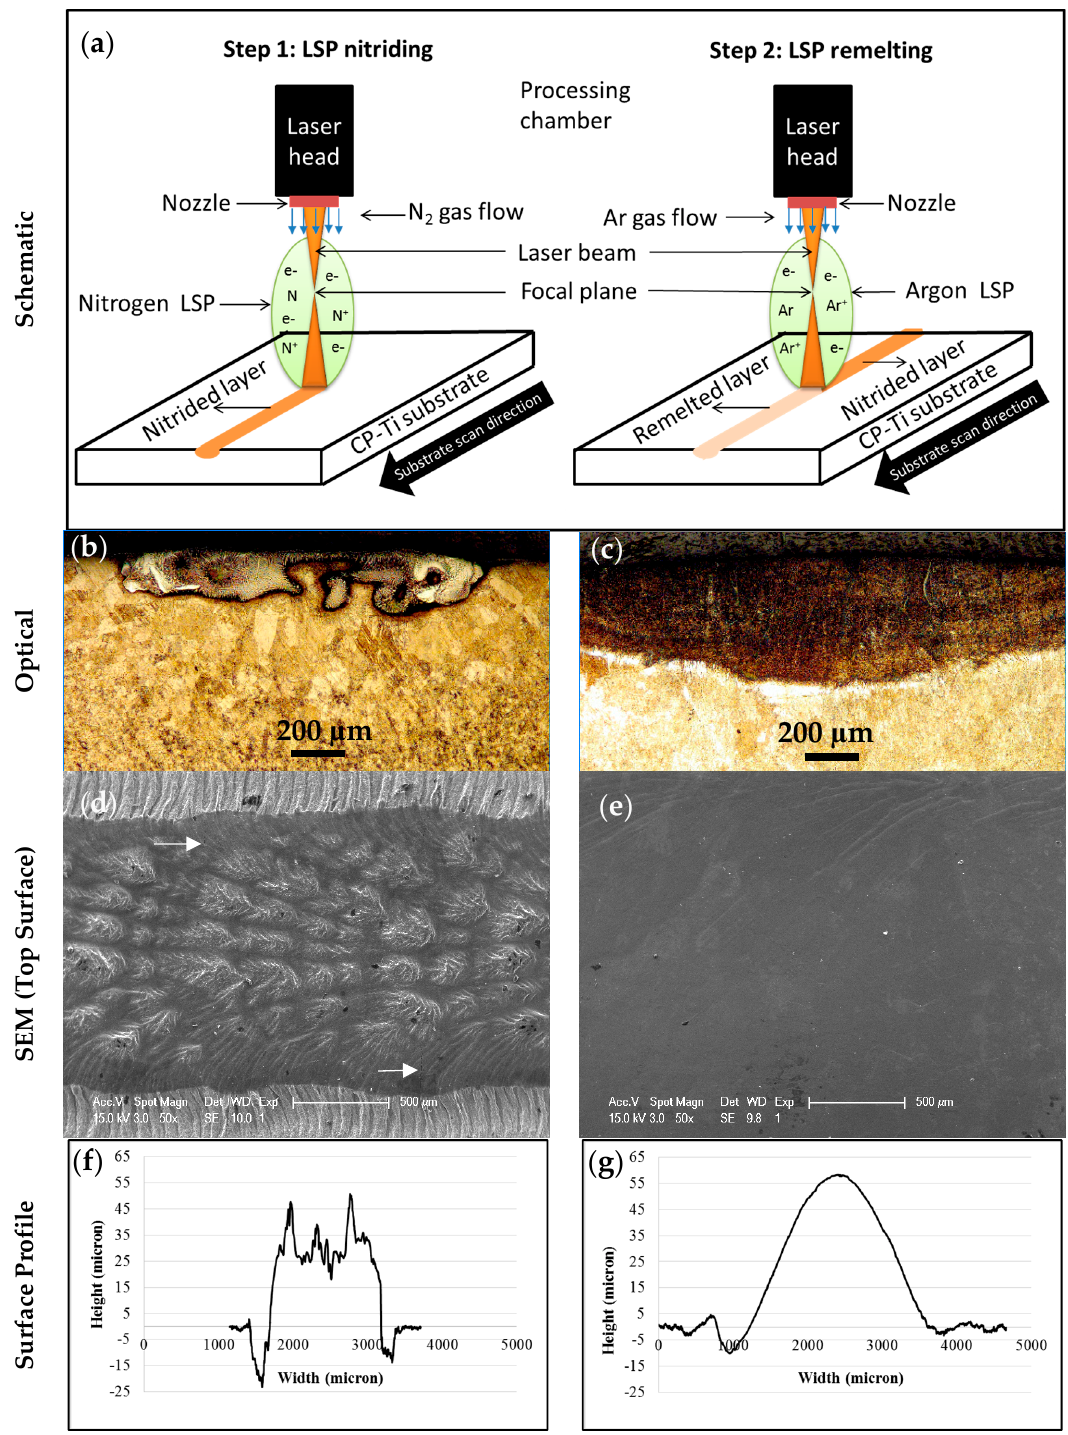
Figure 10. ( a ) Process schematic of two-step LSP nitriding and remelting process; transverse cross- sectional microstructure ( b ) before remelting and ( c ) after remelting; surface microstructure ( d ) before remelting and ( e ) after remelting; surface roughness across the width of the trail ( f ) before remelting and ( g ) after remelting. White arrows in ( d ) point to surface cracks. Reprinted with permission from Ref. [106]. Copyright 2017 Elsevier.